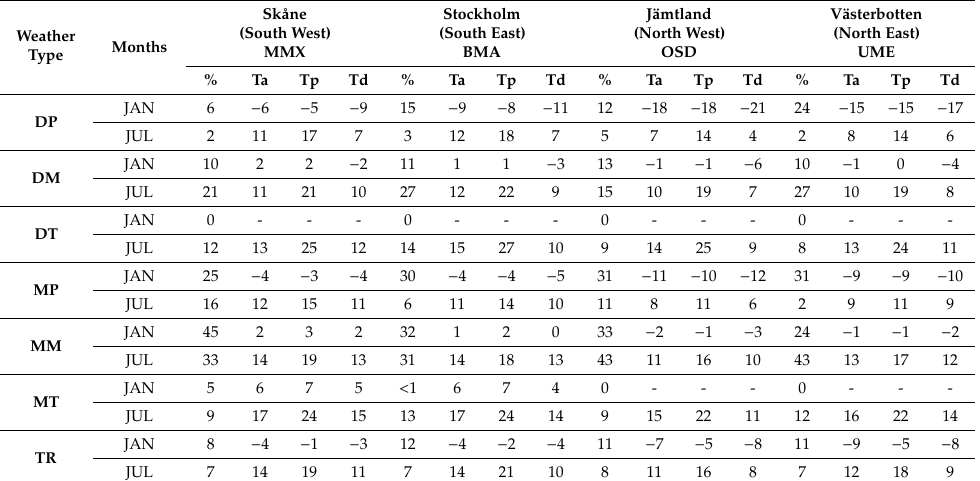
Table 1. Characteristics of each weather type for January and July at each